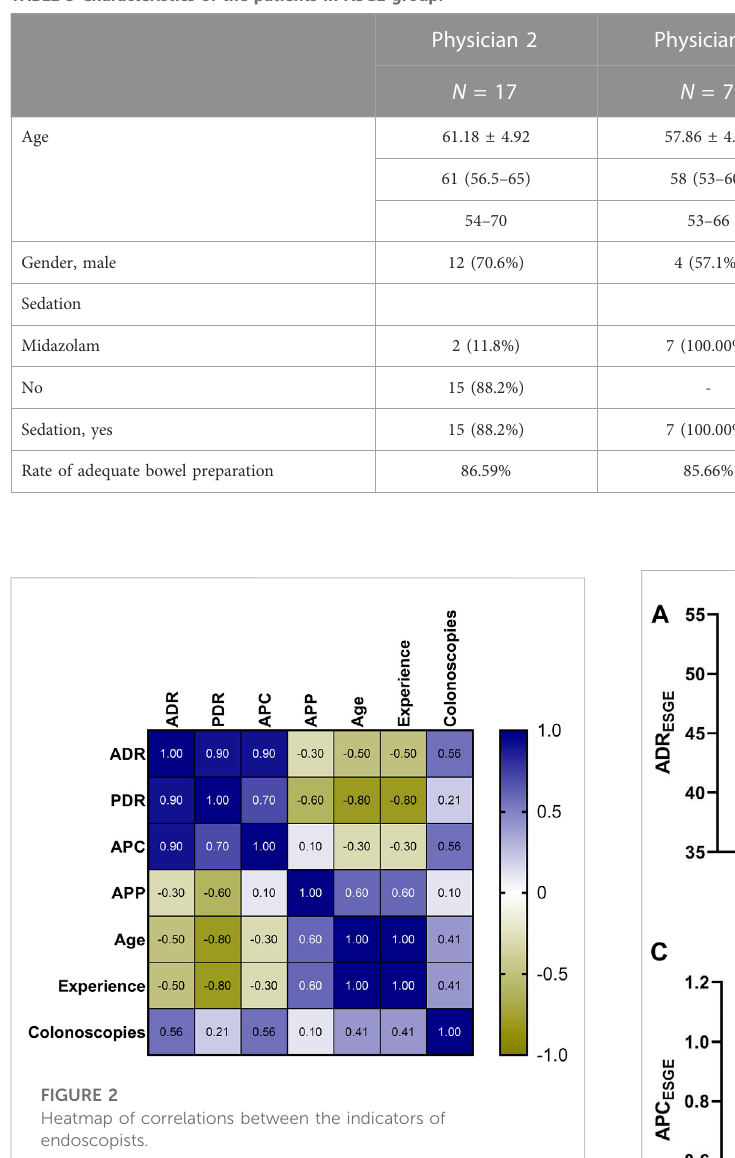
FIGURE 2 Heatmap of correlations between the indicators of endoscopists.